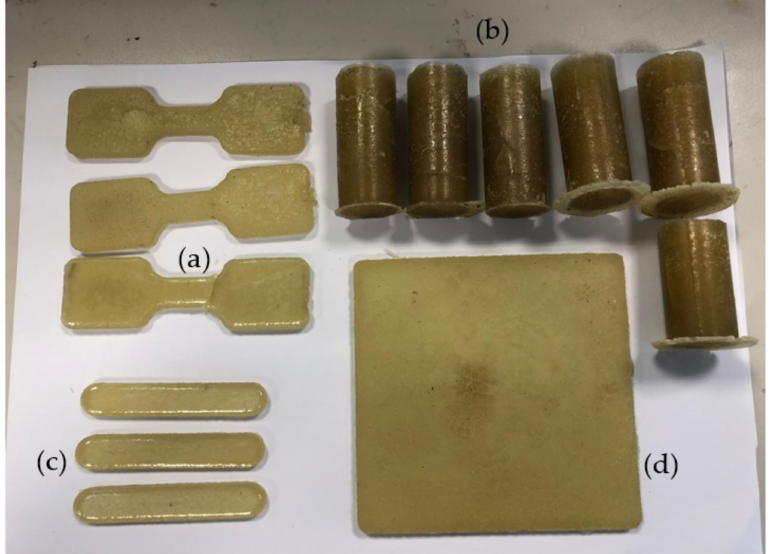
Figure 1. UPR-PUD composite samples for ( a ) Tensile test, ( b ) compression and water retention tests, ( c ) flexural test and ( d ) thermal conductivity